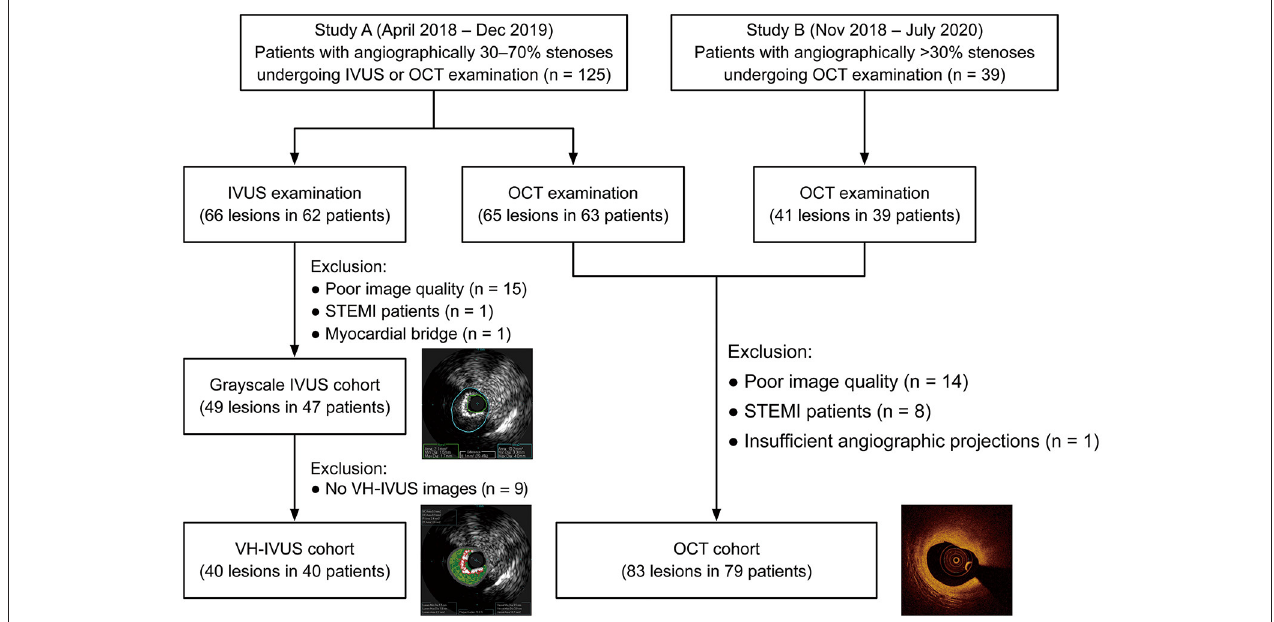
FIGURE 2 | Study flow diagram. IVUS, intravascular ultrasound; OCT, optical coherence tomography; STEMI, ST-segment elevation myocardial infarction; VH-IVUS, virtual histology intravascular ultrasound.